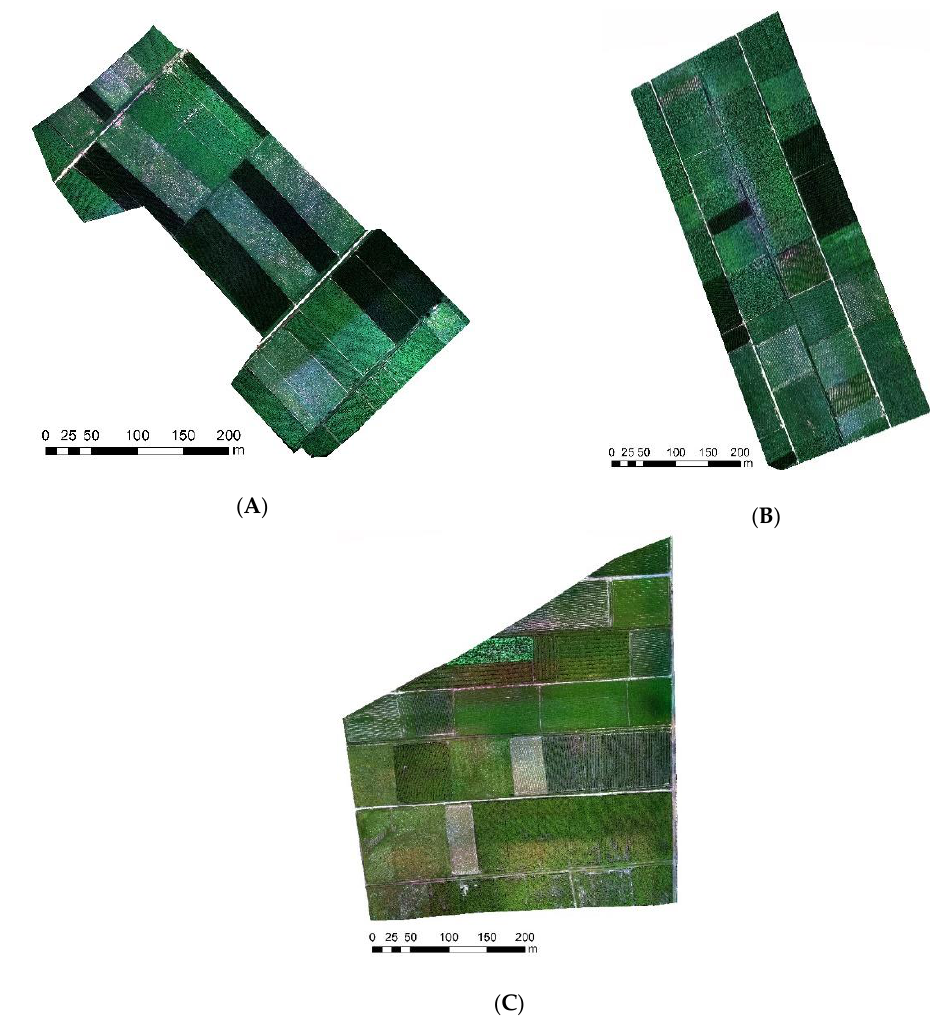
Figure 2. UAV images mosaic results of the study areas.(( A ) UAV images mosaic result of study area 1; ( B ) UAV images mosaic result of study area 2; ( C ) UAV images mosaic result of study area 3)